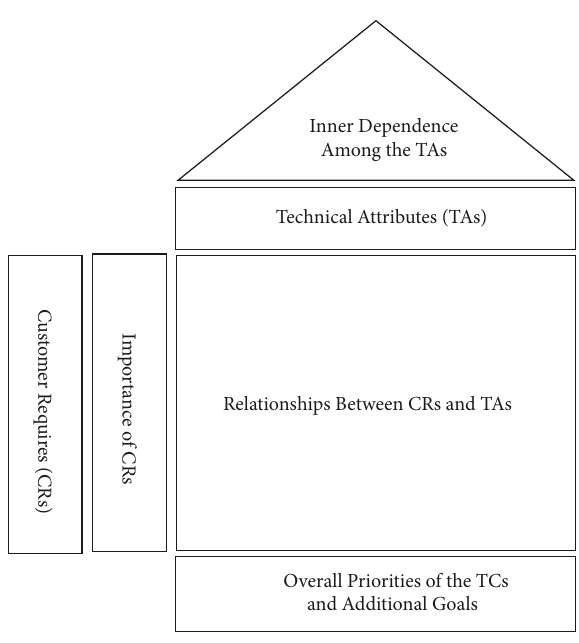
Figure 1: Flow chart of QFD